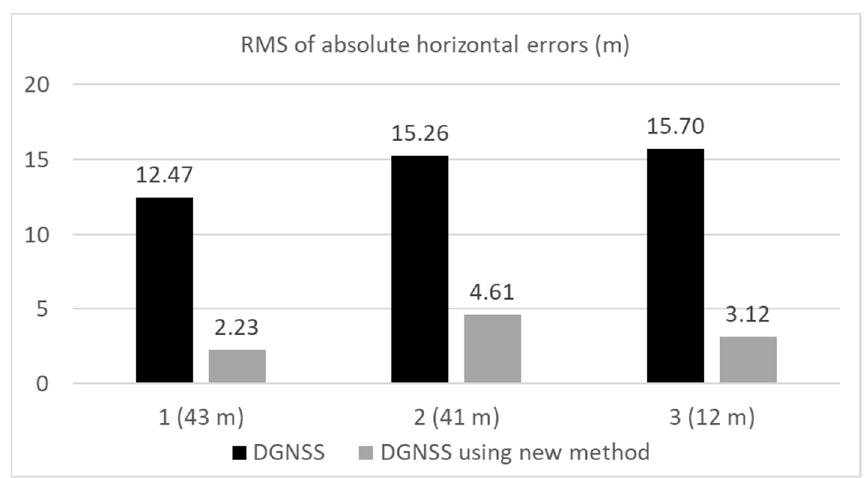
Figure 22. Comparison of DGNSS RMS errors in three locations. Sensors 2018 , 18 , x FOR PEER REVIEW